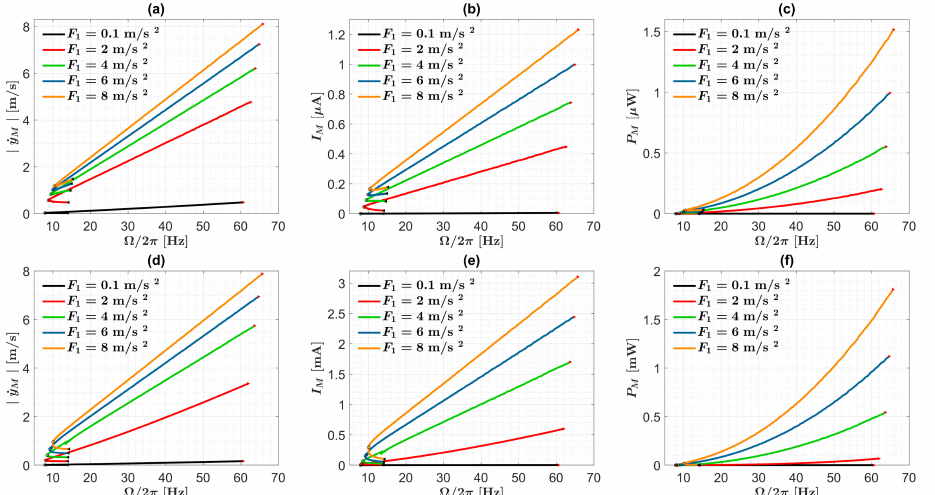
Figure 5. Optimal levitating magnet velocities, electric currents and power for five excitation ampli- tudes when ∆ d changes from − d 0 /2 to d 0 /4: ( a – c ) | ˙ y M | , I M and P M for R l = 1 M Ω ; ( d – f ) | ˙ y M | , I M and P M for R l = 188 Ω . ∆ d = 0 is identified by a black circle